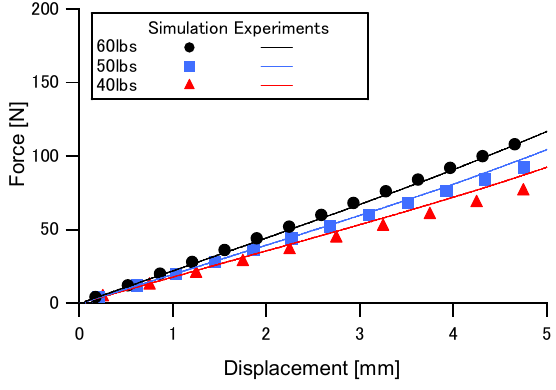
Figure 9. Effect of string tension on stiffness in out-of-plane direction.